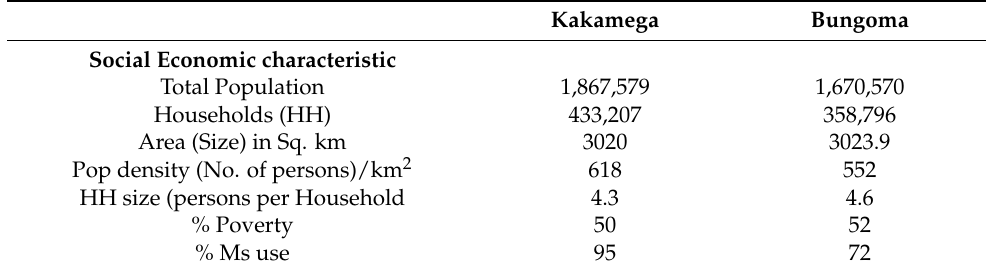
Table 1. Social–economic characteristics for Kakamega and Bungoma Counties, Western Kenya.